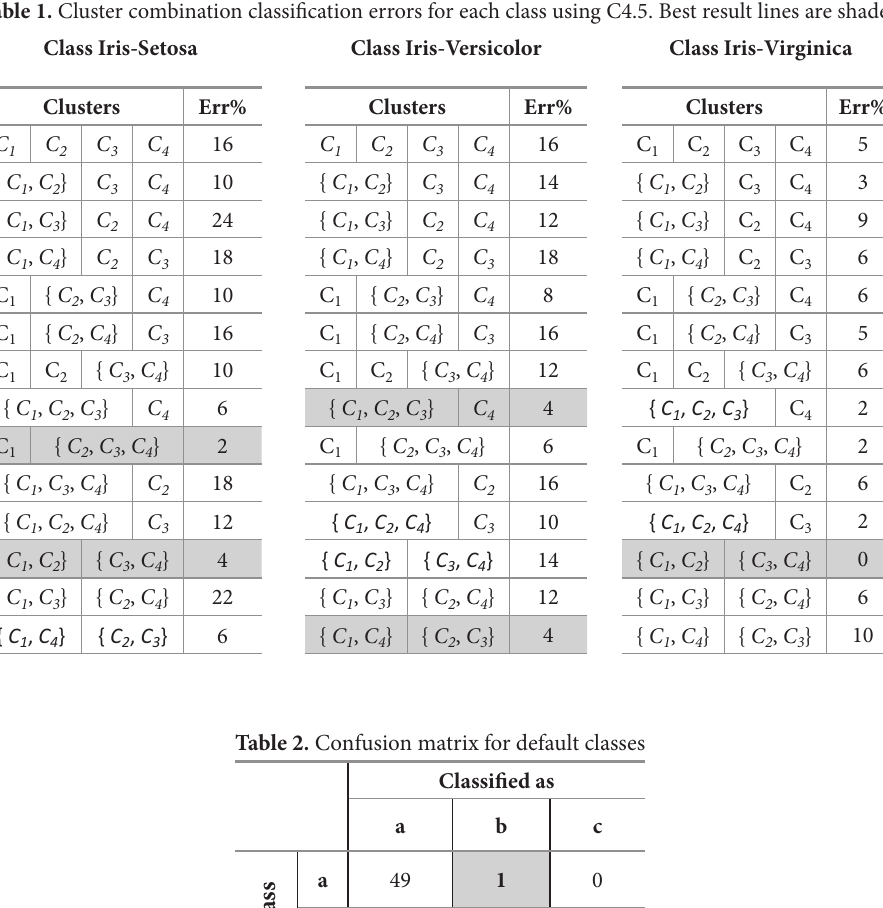
2. Table 2 (classes are as follows: a – Iris-setosa, b – Iris-versicolor, c – Iris-virginica).